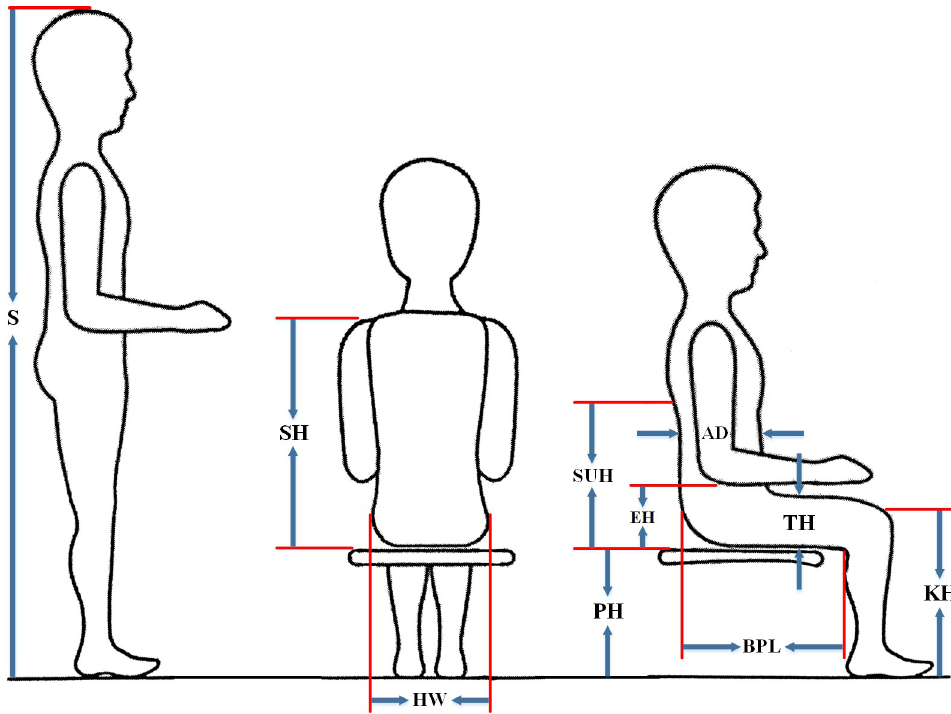
Fig 2. Representation of the anthropometric